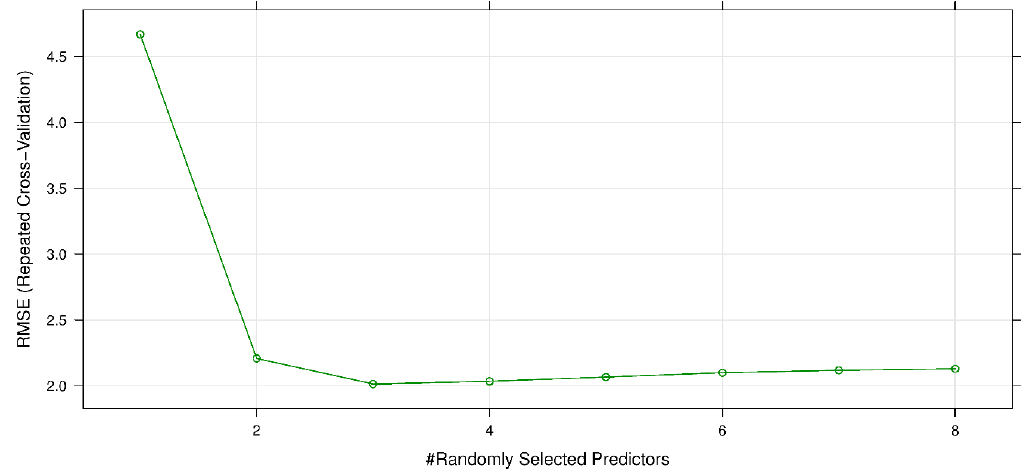
Figure 8. The development process of the random forest (RF) model for estimating HL.